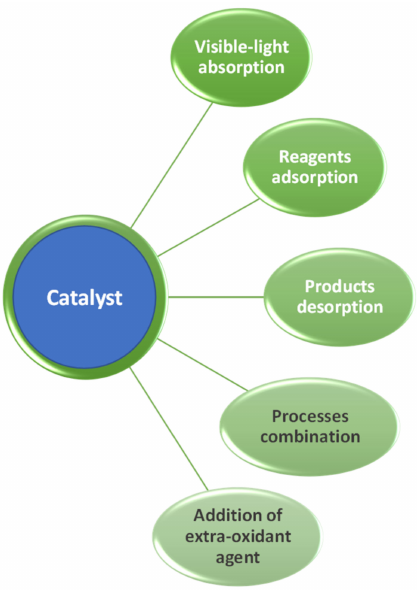
Figure 3. Main strategies developed for process intensification via